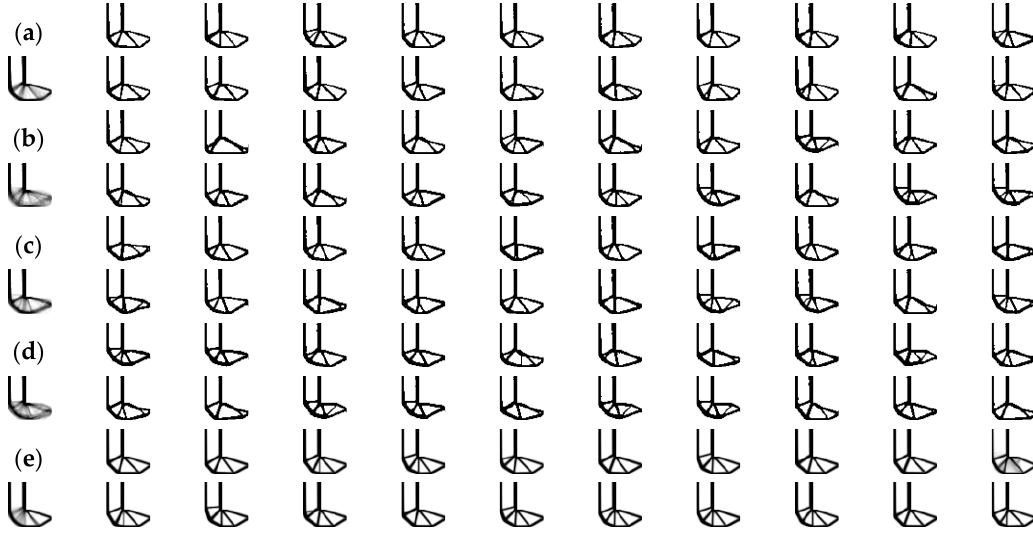
Figure 9. Generated options and stacked views of the cantilever beam by ( a ) ε -greedy policy, ( b ) UCB algorithm with BESO, ( c ) TS method with beta distribution, ( d ) TS method with Gaussian distribution, and ( e ) UCB algorithm with SIMP.